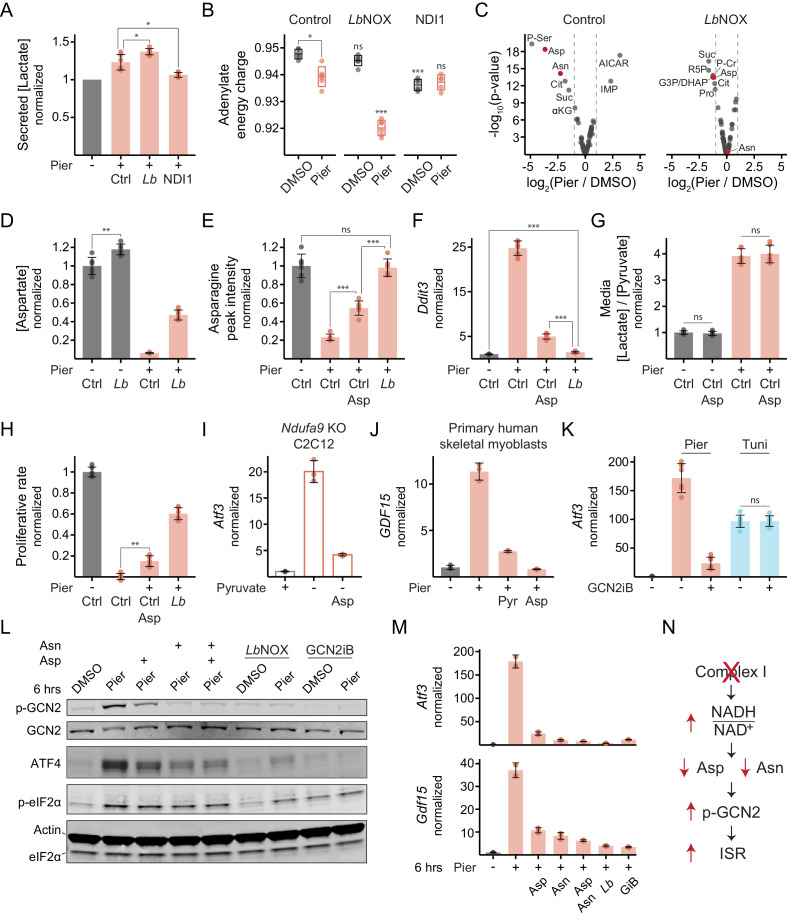
Complex I inhibition in myoblasts triggers the ISR through the kinase GCN2 due to an aspartate and asparagine deficiency.(A) Secreted [lactate] following 2 hr piericidin treatment in control (Ctrl), LbNOX (Lb) or NDI1 cells. Data is normalized to DMSO (-) separately for each cell line. Mean ± SD, N = 6 from three experiments (same samples as in Figure 3D). Welch’s t-test (two-tailed) was used to compare control with LbNOX and NDI1 cells, followed by Holm’s correction for multiple testing. (B) Adenylate energy charge following 1 hr piericidin treatment in control, LbNOX or NDI1 cells. Mean ± SD, N = 5–6 from two experiments. The Games-Howell test was used to make all pairwise comparisons. Notations with no connecting lines relate to the equivalent treatment in control cells. (C) Fold-change (x-axis) and statistical significance (y-axis) of metabolite differential abundance following 1 hr piericidin treatment in extracts of control or LbNOX cells. N = 3. P-Ser, phosphoserine; Asp, aspartate; Asn, asparagine; Cit, citrate; Suc, succinate; αKG, α-ketoglutarate; IMP, inosine monophosphate; AICAR, 5-aminoimidazole-4-carboxamide ribonucleotide; R5P, ribose 5-phosphate; G3P/DHAP, glyceraldehyde 3-phosphate and/or dihydroxyacetone phosphate; P-Cr, phosphocreatine; Pro, proline. Detailed results are provided in Figure 4—source data 1. (D) Intracellular [aspartate] following 1 hr piericidin treatment in control or LbNOX cells. Data is normalized to DMSO in control cells. Mean ± SD, N = 6 from two experiments (includes samples shown in C). The Games-Howell test was used for all pairwise comparisons. (E) Peak intensity of intracellular asparagine following 1 hr piericidin treatment in control cells, with or without aspartate, and in LbNOX cells. Data is normalized to DMSO in control cells. Mean ± SD, N = 6 from two experiments. The Games-Howell test was used for all pairwise comparisons. (F) qPCR of Ddit3 following 10 hr piericidin treatment in control cells, with or without aspartate, and in LbNOX cells. Data is presented as fold-change from DMSO in control cells. Mean ± SD, N = 8 from three experiments. The Games-Howell test was used to make all pairwise comparisons of ΔΔCt values. (G) Media [lactate]/[pyruvate] following 2 hr piericidin treatment, with or without aspartate, in control cells. Data is normalized to DMSO without aspartate. Mean ± SD, N = 6 from three experiments. Welch’s t-test (two-tailed) was used to compare each treatment with and without aspartate, followed by Holm’s correction. (H) Proliferative rate (doublings in 24 hr) of control cells, with or without aspartate, and of LbNOX cells following piericidin treatment. Data is normalized to DMSO in control cells. Mean ± SD, N = 5–6 from three experiments. The Games-Howell test was used for all pairwise comparisons. (I) qPCR of Atf3 following 10 hr pyruvate withdrawal, with or without aspartate, in Ndufa9-KO C2C12 myoblasts. Data is presented as fold-change from the condition with pyruvate (+). Mean ± SD, N = 3. (J) qPCR of GDF15 following 10 hr piericidin treatment, with or without pyruvate or aspartate, in primary human skeletal myoblasts. Data is presented as fold-change from DMSO. Mean ± SD, N = 3. (K) qPCR of Atf3 following 10 hr piericidin or tunicamycin (Tuni) treatment, with or without GCN2iB, in control cells. Data is presented as fold-change from DMSO. Mean ± SD, N = 6-7. Welch’s t-test (two-tailed) was used to compare each treatment with and without GCN2iB, followed by Holm’s correction. (L) Western blot of (p-)GCN2, ATF4 and (p-)eIF2α following 6 hr piericidin treatment in the indicated conditions in LbNOX cells. LbNOX expression was induced only where indicated. (M) qPCR of Atf3 and Gdf15 in the same cells and conditions shown in L. Data is presented as fold-change from DMSO. Mean ± SD, N = 2–3. GiB, GCN2iB. (N) Model for ISR activation by complex I inhibition in myoblasts. ns, p>0.05; *, p<0.05; **, p<0.01; ***, p<0.001.Figure 4—source data 1.Metabolite profiling data.